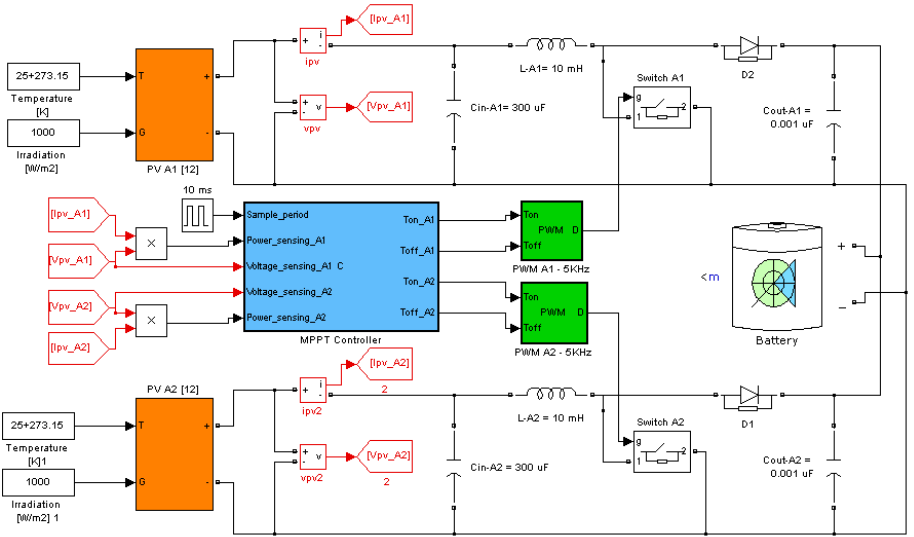
Figure 9. Simulation setup.